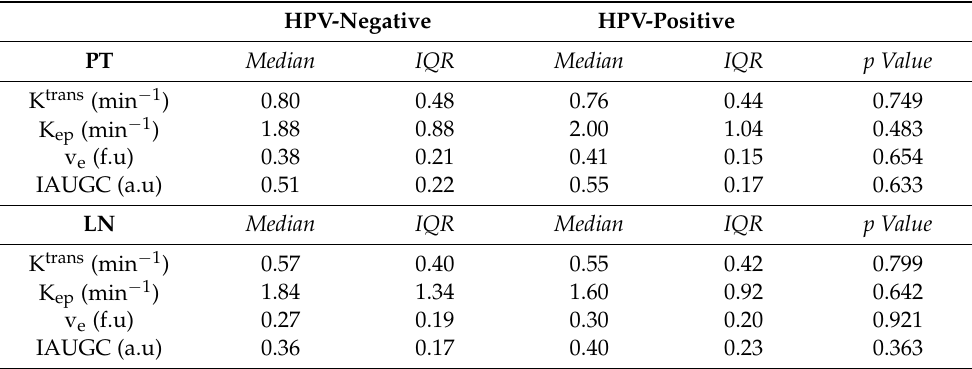
Table 4. Perfusion parameters from DCE-MRI in primary tumors (PTs) and metastatic lymph nodes